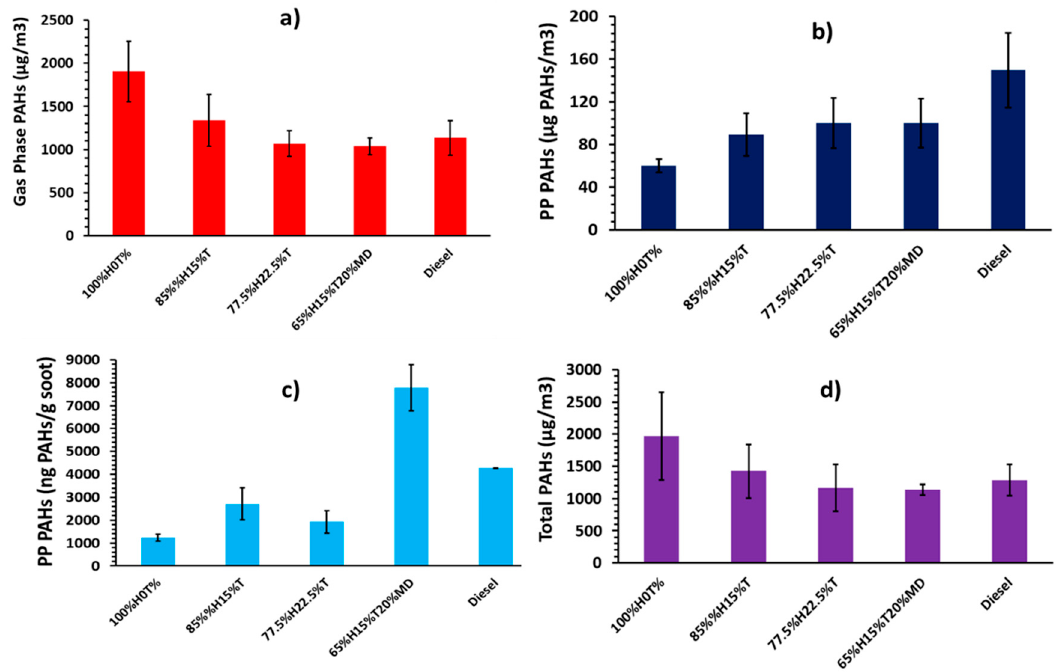
Figure 4. Normalized total PAH concentrations in diesel engine: ( a ) Gas Phase ( µ g of PAH / m 3 of gas), ( b ) Particle Phase ( µ g of PAH / m 3 of gas), ( c ) Particle Phase (ng of PAH / mg of soot) and ( d ) total PAH ( µ g of PAH / m 3 of gas).